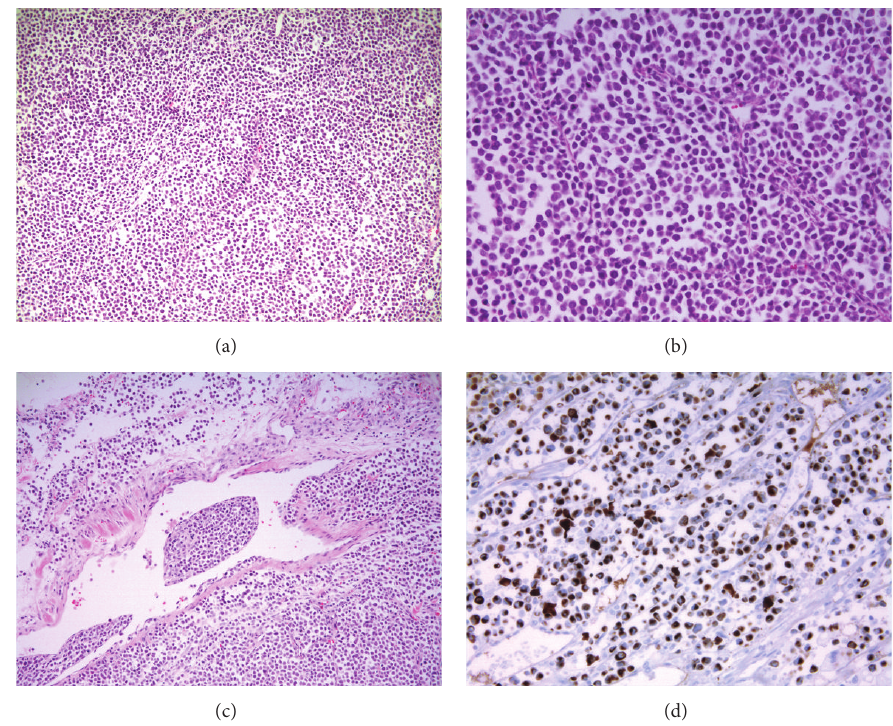
Figure 5: Microscopic findings of the right axillary mass showed diffuse sheets of basophilic tumor cells ((a) HE × 200) with large and pale staining nucleus and tiny nucleoli ((b) HE × 400). Lymphovascular invasion is an almost constant histological finding ((c) HE × 400). Characteristic paranuclear dot-like staining of CK20 is specific for MCC ((d) CK20 × 400).